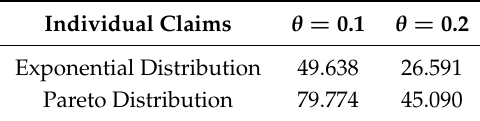
Table 4. The largest initial surplus, u L , for the translated gamma